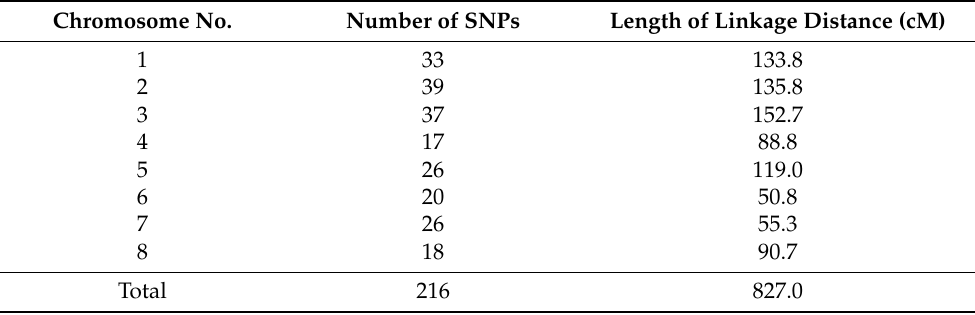
Table 3. Information of the onion genetic linkage map constructed in an F 2 population of ‘16P118 × Sweet